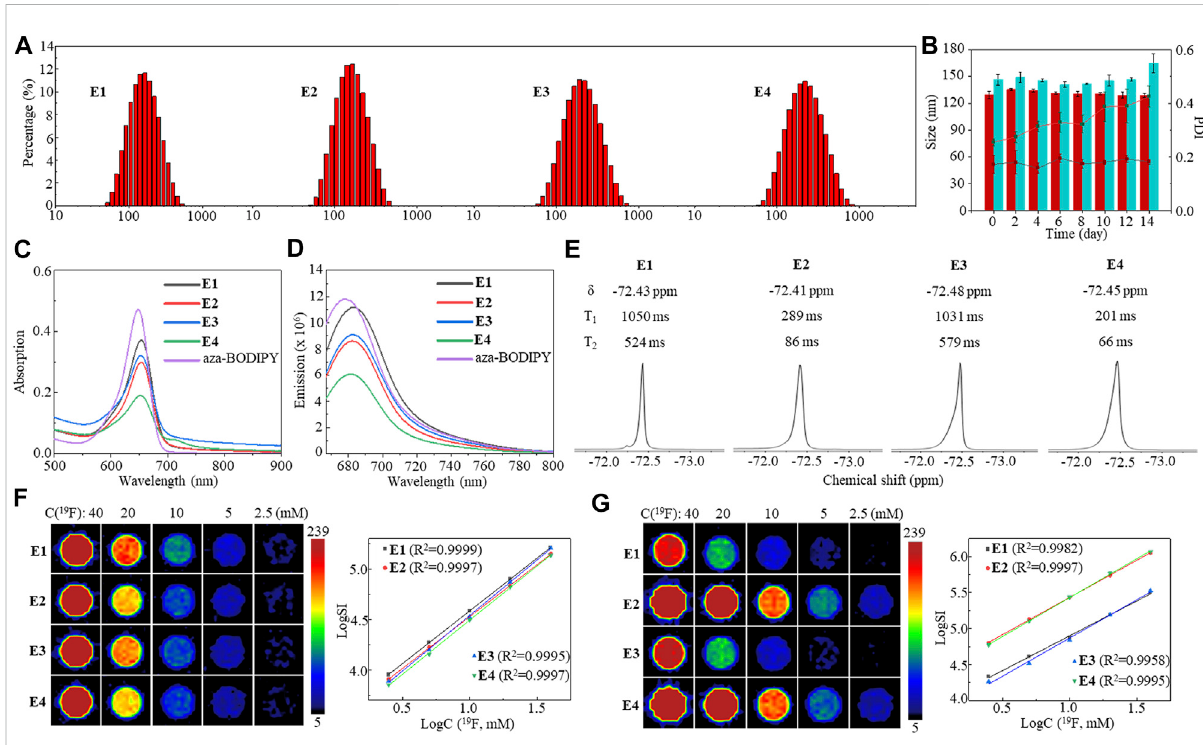
FIGURE 3 DLS (A) , stability monitored by DLS over 14 days (B) , UV-Vis absorption spectra (C) , FL emission spectra (D) , partial 19 F NMR spectra and 19 F relaxationtimes (E) , 19 Fdensity-dependentphantomimagesandthelogarithmplotofSIversus 19 Fconcentration (F) ,and 19 FT 1 -dependentphantom images and the logarithm plot of SI versus 19 F concentration (G) of nanoemulsions E1 –